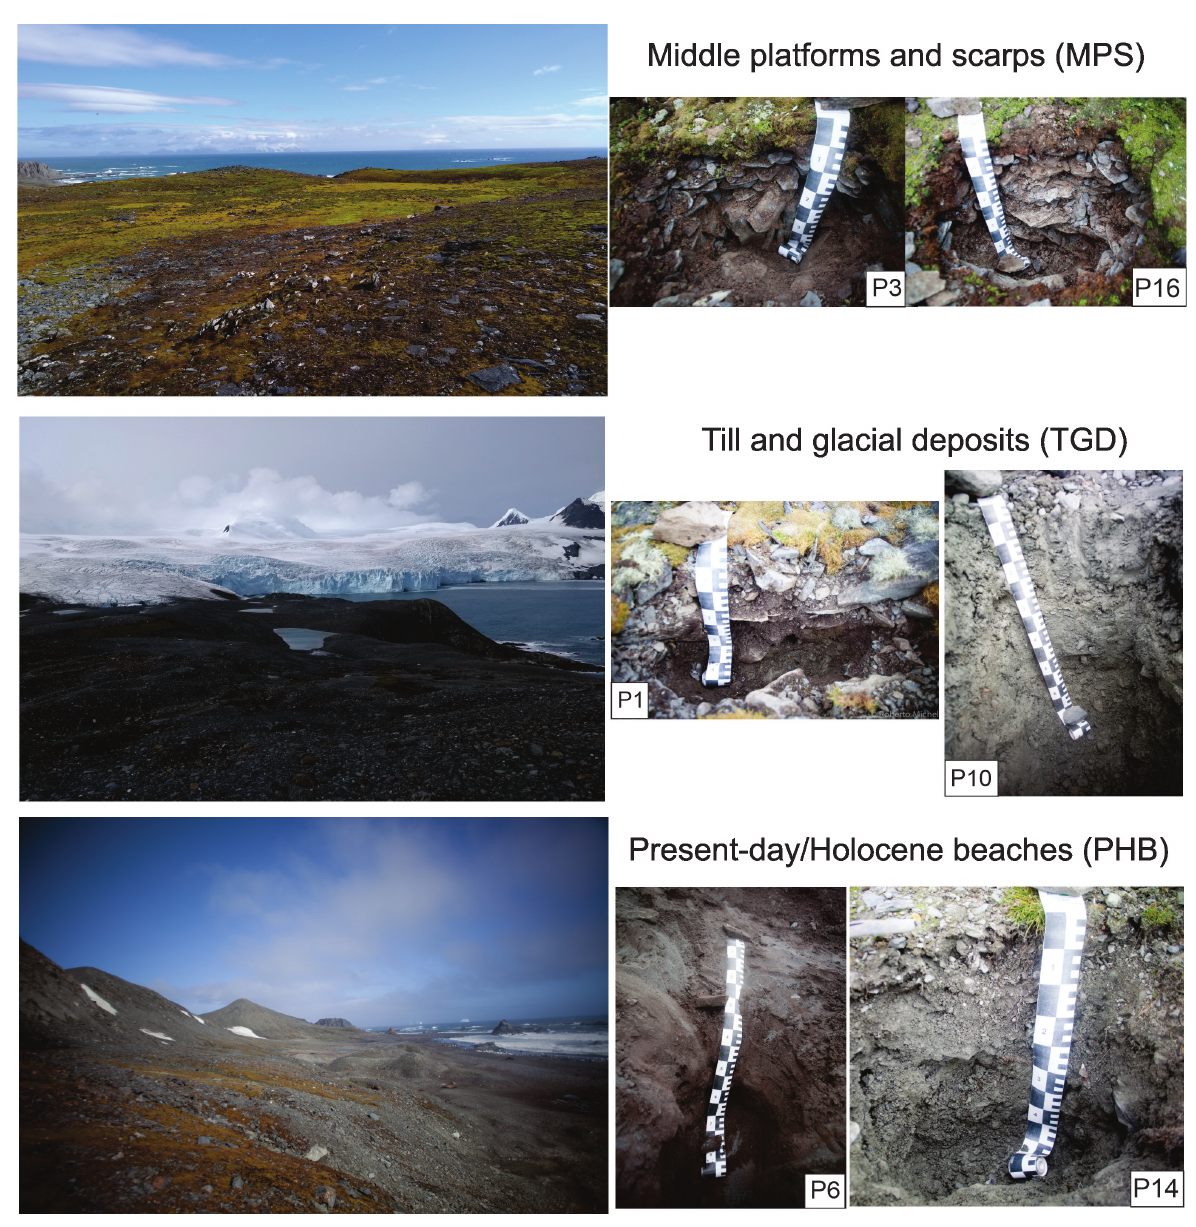
Figure 3. Landforms and representative soil profiles, sampled at Stinker Point: P3 and P16 Middle platforms and scarps, P1 (older soils) and P10 (recently exposed) at Till and Glacial deposit, Present day (P6) and Holocene beaches